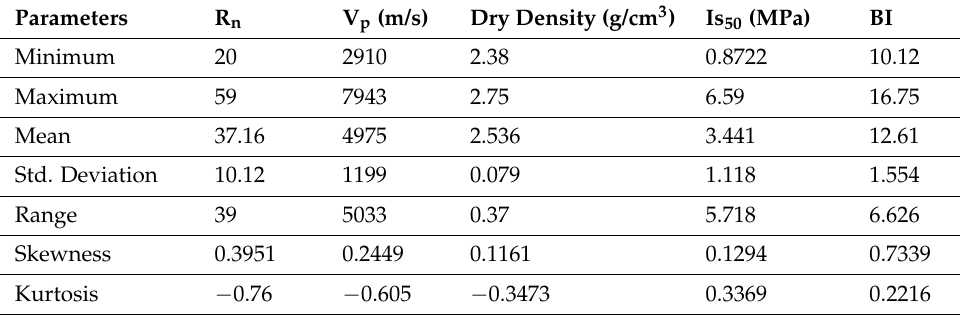
Table 1. Descriptive statistics of all variables used in the modeling.